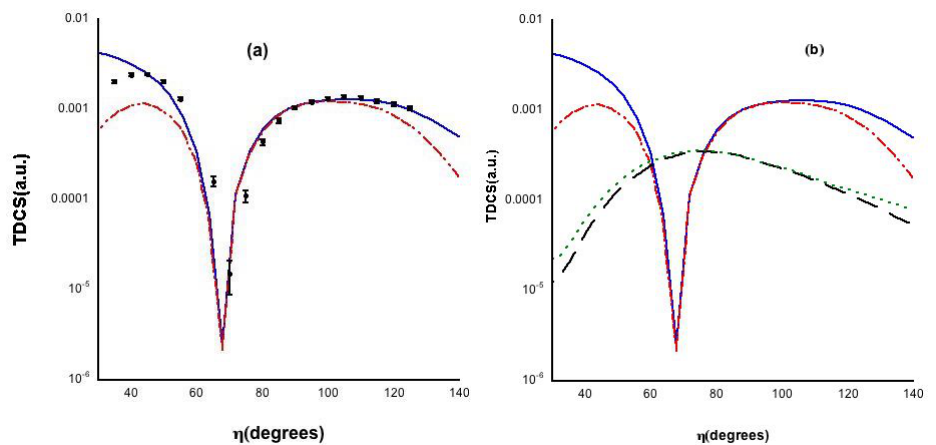
Figure 5. TDCS for ionization of helium with a projectile impact energy of E 0 = 64.6 eV, and “gun angle” of Φ = 67.5 ◦ : ( a ) comparison of theory and experiment for electron impact, experiment [31]: solid blue curve DWBA (using singlet exchange) with no pci; red dashed double dotted DWBA (singlet exchange potential) with pci; ( b ) electron impact as in subfigure ( a ), positron impact black dashed DWBA (singlet exchange potential), no pci, dotted green, DWBA (singlet exchange potential) with